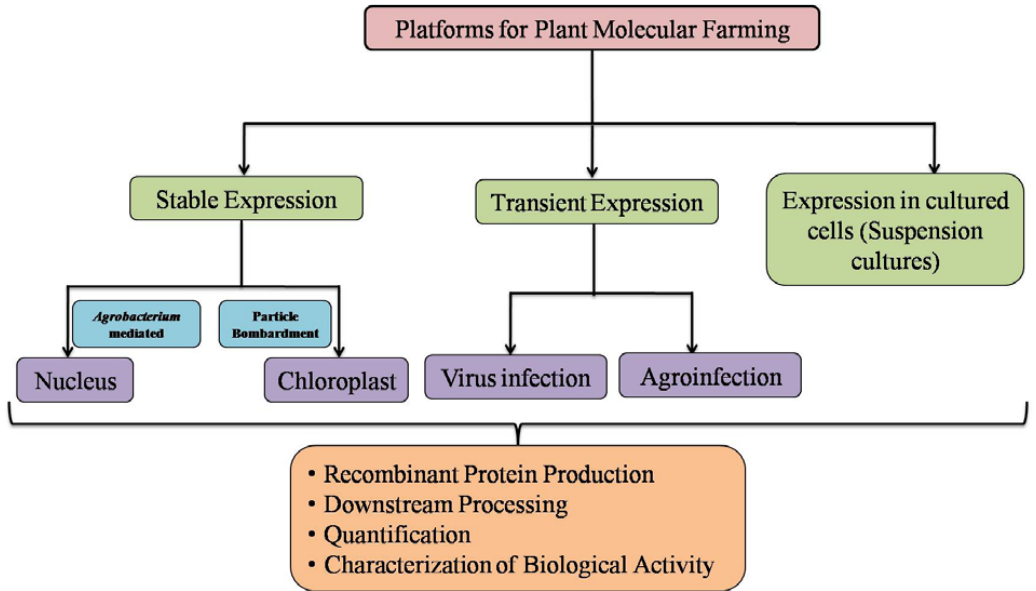
Figure 1. Overview of plant transformation approaches employed for the production of recombinant pharmaceutical and non-pharmaceutical proteins in plants.